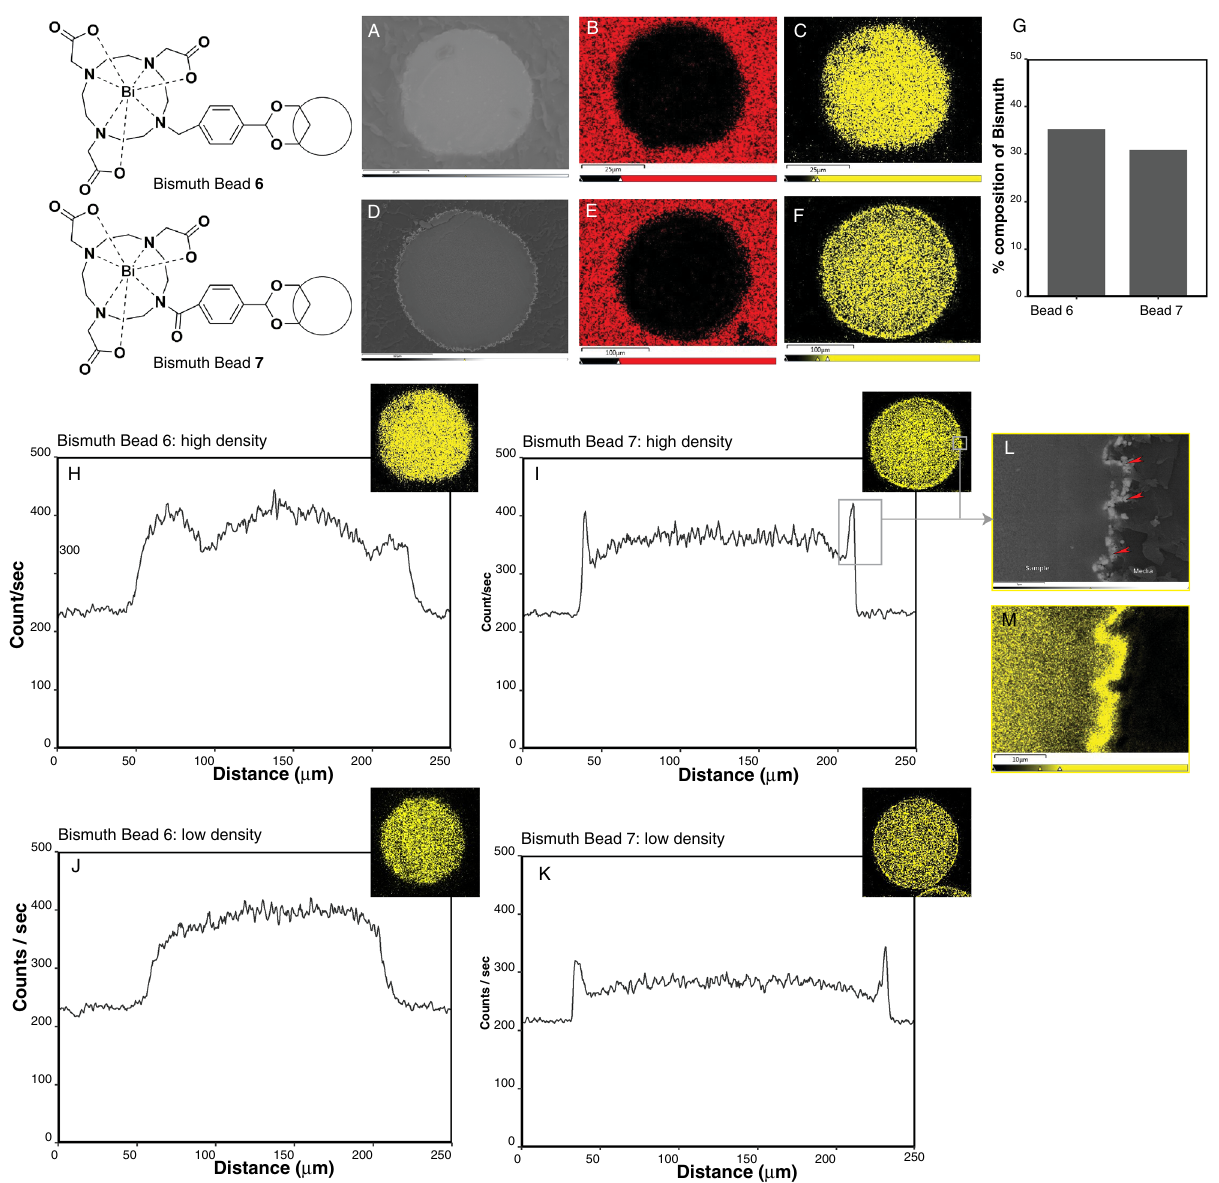
Figure 3 . Scanning electron microscopy (SEM) and associated sulfur and bismuth elemental maps of cross-sections of bead 6 and bead 7 showing bismuth distribution. SEM image for bead 6 ( A ) and bead 7 ( D ). Associated Sulfur elemental maps for bead 6 ( B ) and bead 7 ( E ) and bismuth elemental maps for bead 6 ( C ) and bead 7 ( F ). ( G ) Bar plot of the average percent composition of bismuth in beads 6 and 7 , showing a higher average bismuth concentration for bead 6 compared to bead 7 . Representative bismuth line scans of single beads with a high and low amount of bismuth, with the correlative bismuth elemental map in the upper right corner for each graph for bead 6 ( H , J ) and 7 (I , K ). For bead 6 , the maximum bismuth count/sec was relatively constant within each bead, reflecting a homogenous distribution of bismuth throughout the beads. For bead 7 , there was a peak in the bismuth counts/sec at the edge of the beads with otherwise homogeneous distribution of bismuth in the bead interior. Magnified views of the SEM ( L ) and bismuth element map ( M ) of the higher density bead 7 ( I ) showed an irregular bead edge and an accumulation of bismuth grains at the edge consistent with the bismuth peaks in the line graphs at both edges. Note that a slight increase in signal strength is present in the line scans between 20 and 200 μm. This effect is expected as the electron beam travels farther from the specimen edge. The effect is accentuated due to the small diameter of the spheres and may not indicate an actual increase in